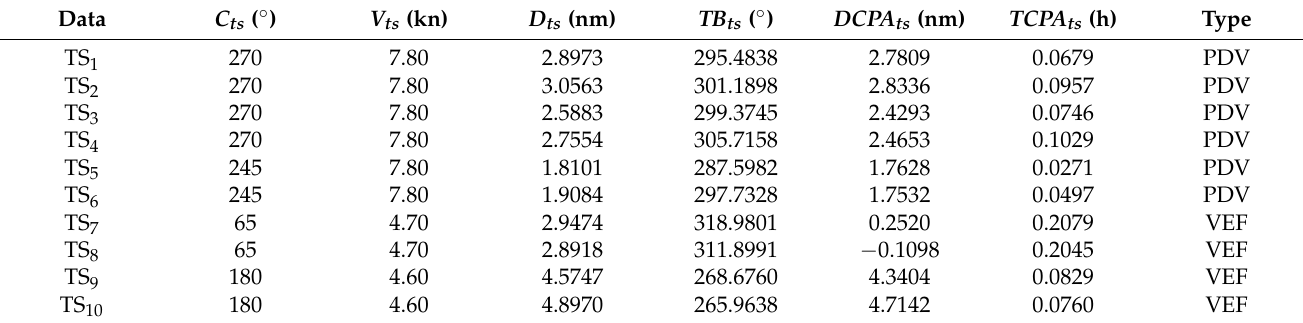
Table 5. Data of target ships at 0018.